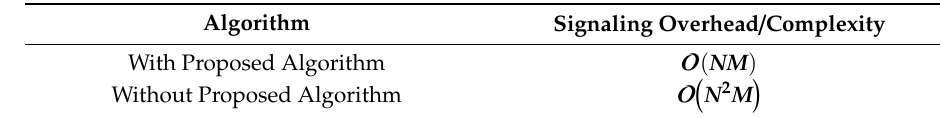
Table 1. Impact of the proposed algorithm on the signaling overhead. Algorithm Signaling Overhead / Complexity With Proposed Algorithm Without Proposed Algorithm